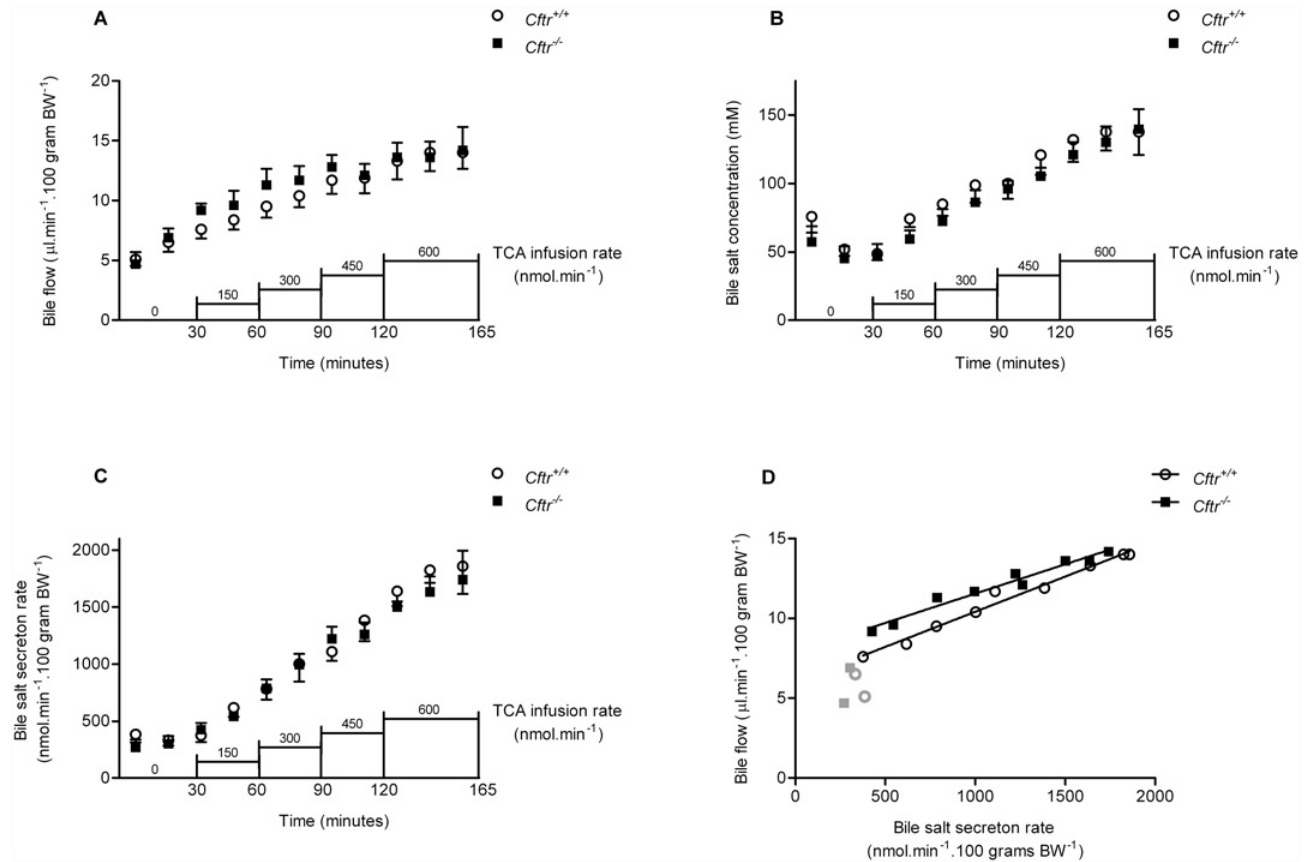
Fig 1. Biliary parameters during intravenous taurocholic acid (TCA) administration. Biliary bile flow (A), bile salt concentration (B), bile salt secretion rate (C) and relationship between bile salt secretion rate and bile flow (D) in Cftr knockout mice ( Cftr — / ) and control littermates ( Cftr +/+ ) during intravenous infusion with TCA in stepwise increasing dosage of. The gray symbols in (D) represent baseline values before the start of TCA infusion. Data are presented as means ± SEM of N = 5 – 7 mice per group. There was no significant difference between Cftr -/- and Cftr +/+ mice, at any of the individual time points, for bile flow, bile salt concentration and bile salt secretion rate (regression lines:. Cftr -/- : y = 0.0044x + 7.9 vs. Cftr +/+ : y = 0.0037x + 6.0).